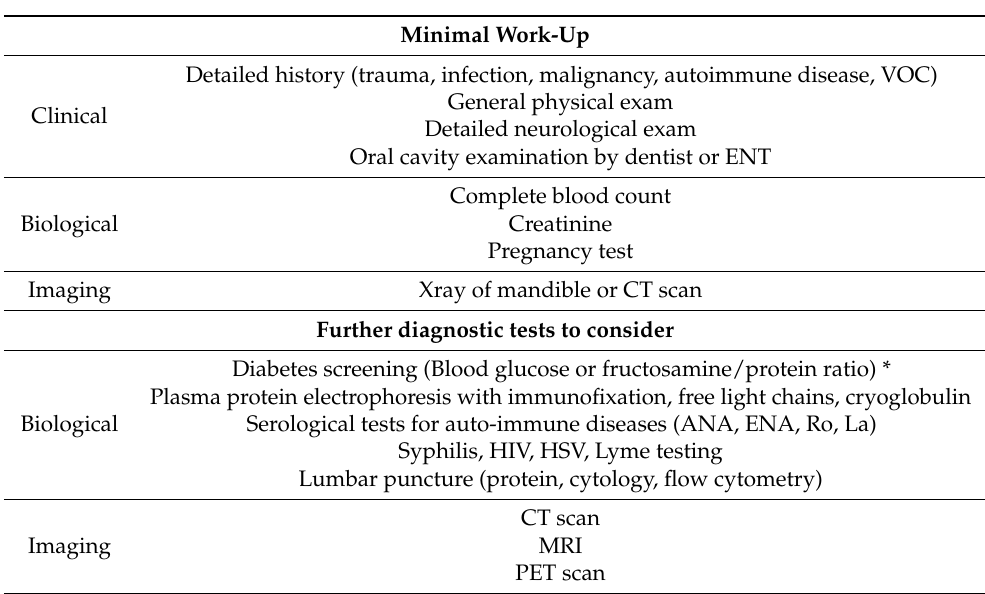
Table 2. Proposed work-up for numb chin syndrome in sickle cell